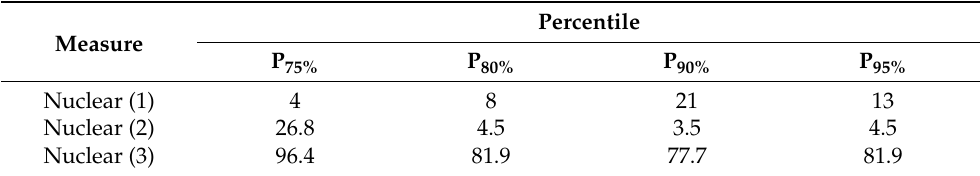
Table 3. Nuclearity for Cracow urban sprawl excluding extreme building